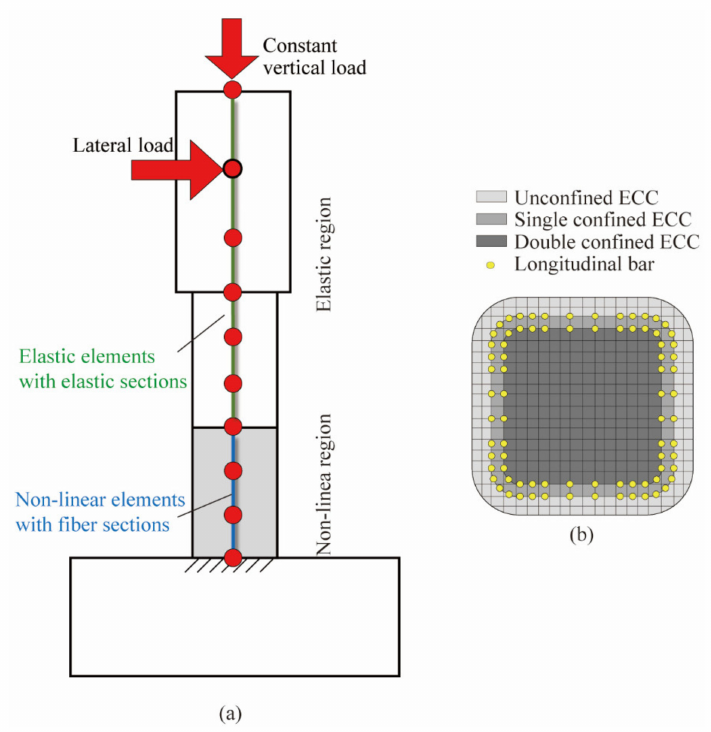
Figure 5. Detail of analytical model. ( a ) Fiber element model, ( b ) Division of